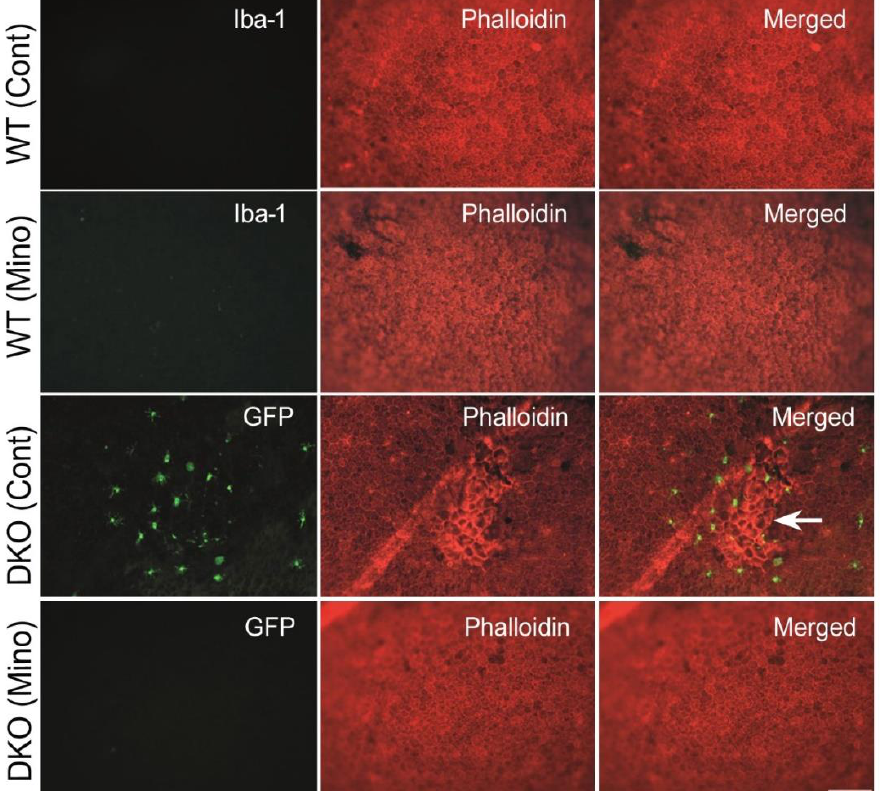
Figure 9. The effect of minocycline on the structure of retinal pigment epithelial cells. RPE/choroidal flatmounts were stained with phalloidin (red) and Iba-1 (green, for wild-type mice). Microglia in double knockout (DKO) mice were GFP + . Arrow indicating RPE dysmorphia and microglial accumulation. Scale bar = 100 μm. RPE: retinal pigment epithelium .